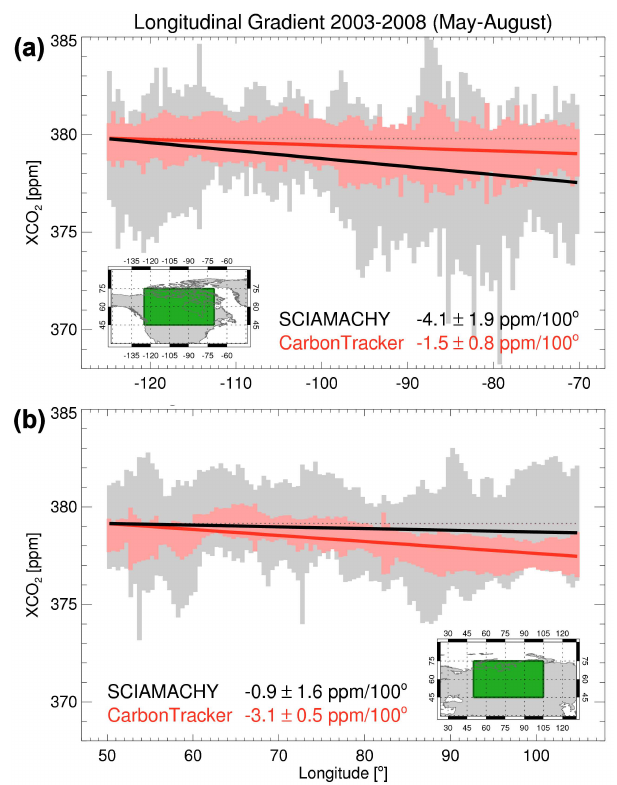
Fig. 7. Linear fits of the west-to-east longitudinal gradients of sea- sonally averaged (May–August) SCIAMACHY (black) and Car- bonTracker (red) XCO 2 during 2003–2008 for (a) North Amer- ica and (b) Russia weighted according to the standard deviations (shaded areas) of the meridional averages (0.5 ◦ bins). The associ- ated errors are derived from the square root of the covariance of the linear fit parameter.